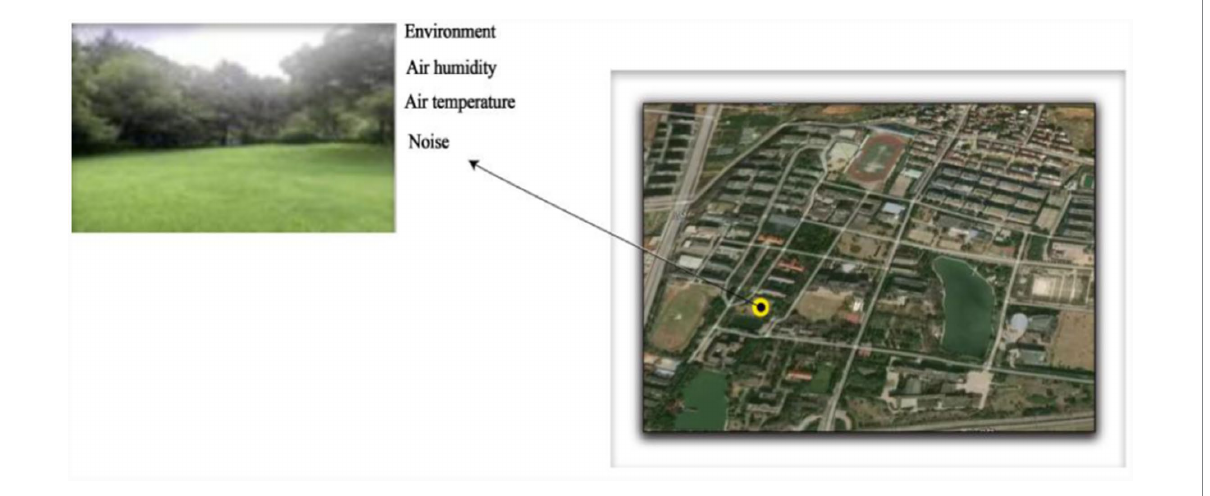
FIGURE 2 Satellite image and real image of the experimental test